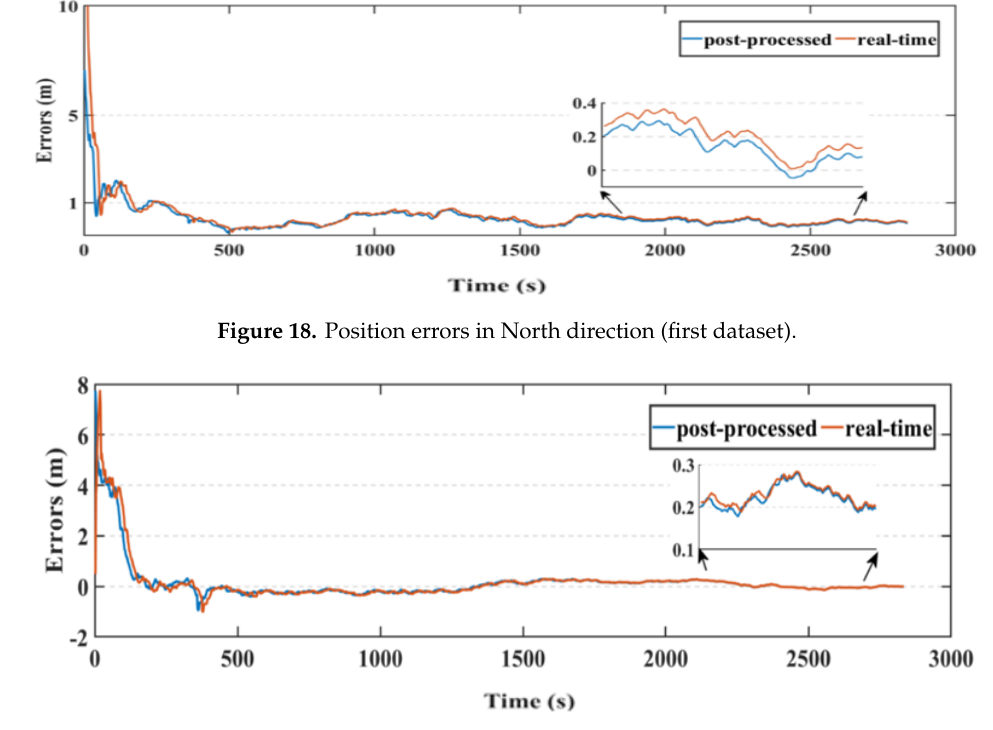
Figure 19. Position errors in Up direction (first dataset).